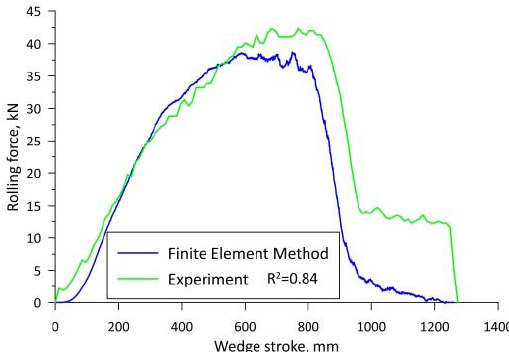
Figure 2. Summary of rolling forces obtained during the experiment and determined by the finite element method.